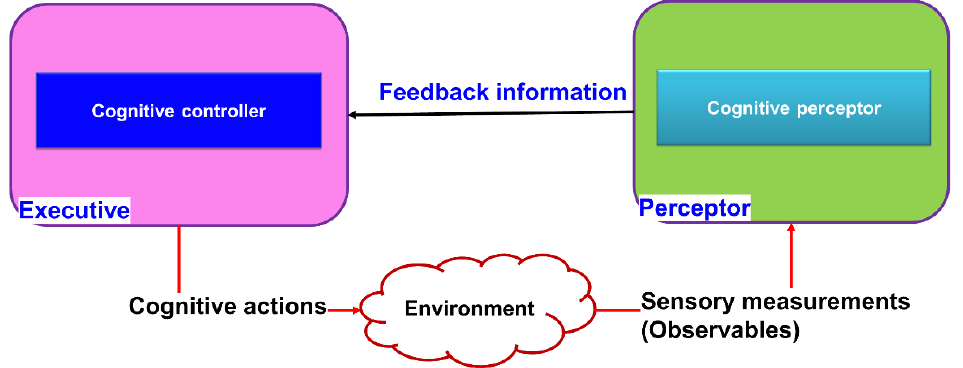
Figure 10. Block diagram of the overall perception – action cycle in a cognitive dynamic system. The CC algorithm in [10] is validated experimentally with a cognitive tracking radar benchmark. Particularly, the CC algorithm in [10] used for planning was compared with tracking radars without CC, CC without planning, and RL (here, Q-learning). Although CC is computationally more expensive than the other algorithms are, CC outperform significantly radar with a fixed waveform shape, RL, and CC without planning.